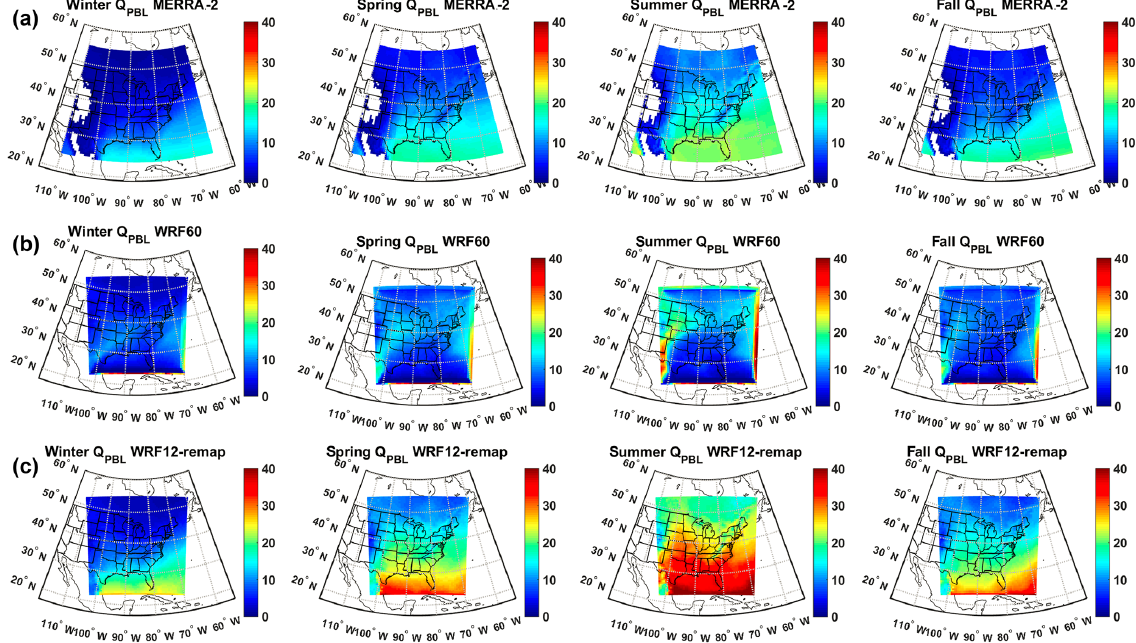
Figure 6. Seasonal mean specific humidity (kgm − 2 ) integrated from the surface to 825hPa ( Q PBL ) from MERRA-2 (first row) assuming an average air density in the PBL of 1.1kgm − 3 , WRF60 (second row) and WRF12-remap (third row). The data are 3-hourly and show only cloud-free hours in all three data